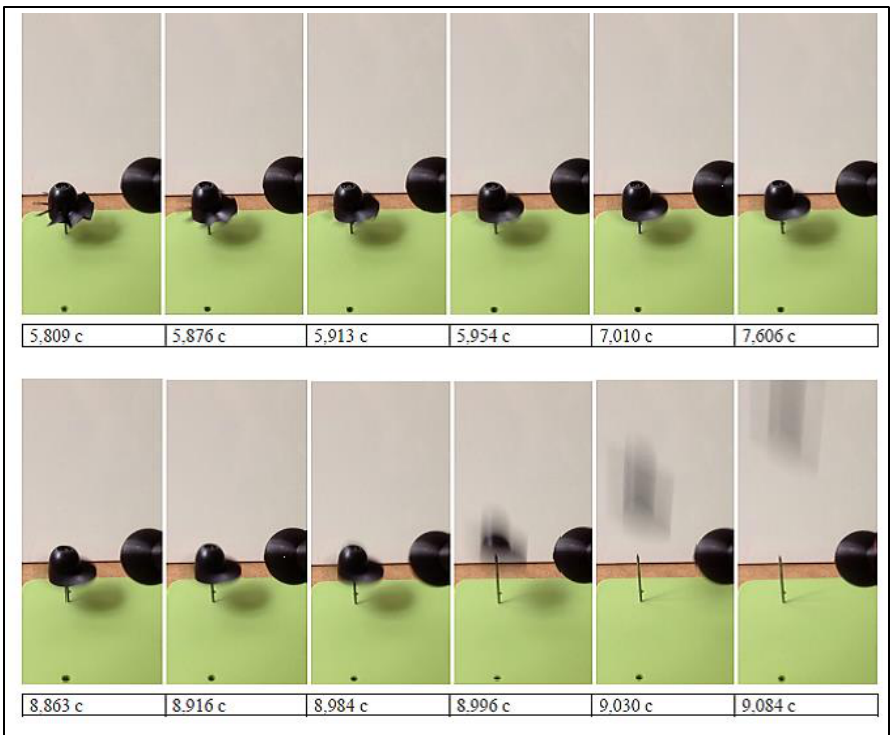
Figure 35. A set of frames from the video recording of the demonstration experiment.